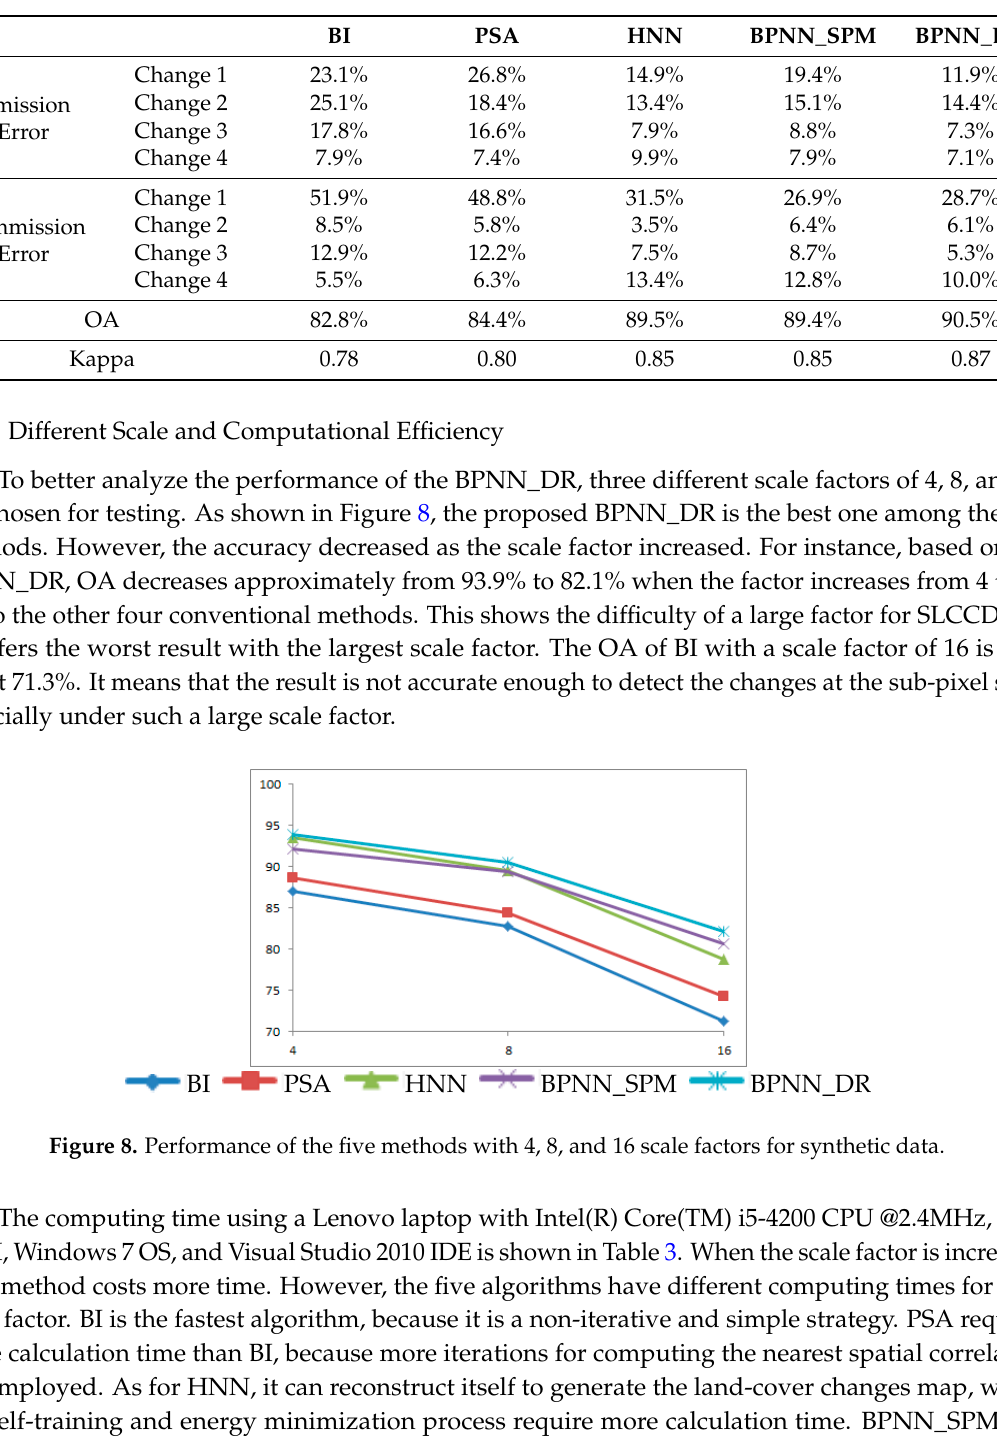
Table 3. Time costs of the five methods with 4, 8, and 16 scale factors for synthetic data.